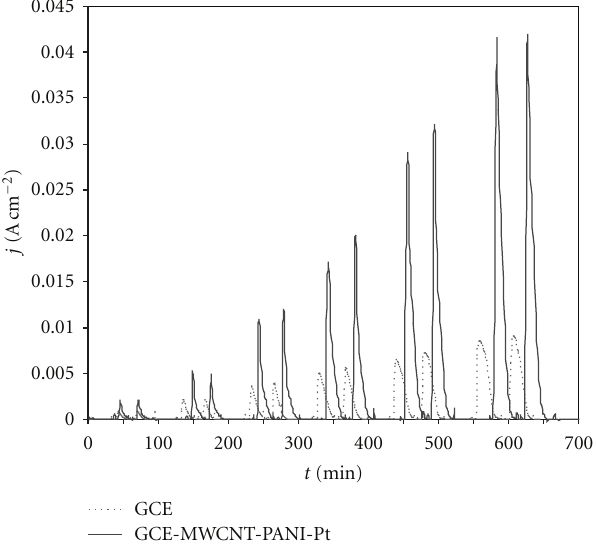
Figure 4: Amperometric detection with FIA technique of ionic iron at 0.412 V versus Ag/AgCl over GCE and GCE-MWCNT-PANI-Pt, in 0.1M KCl at 298